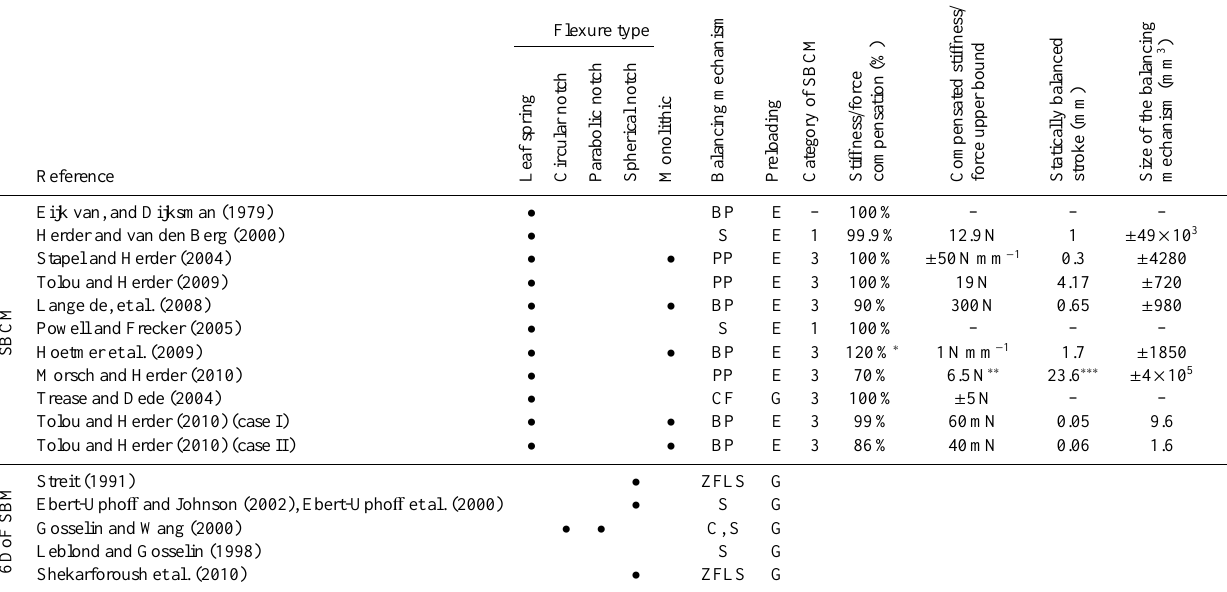
Table 3. Overview of the results of the statically balanced compliant mechanisms (SBCM) and 6DoF statically balanced mechanisms (SBM). The balancing mechanism is either with counterweights (C) or elastic elements, using springs (S), zero-free-length springs (ZFLS) or compliant flexures (CF), which are categorized into the use of buckling plates (BP), preloaded plates (PP), to balance strain energy (E) or gravity forces (G). Data not available identified with